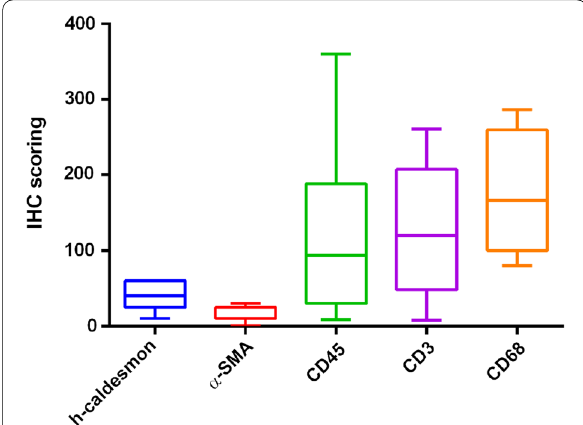
Fig. 1 Immunohistochemistry scoring of h‑caldemon, α‑smooth muscle actin (α‑SMA), CD45, CD3 and CD68 investigated in this study. α‑SMA and h‑caldesmon stains were used to quantify the percentage of the fibrous rupture of the tunica media of the muscular arteries CD45, CD3, and CD68 stains assessed the count of leukocytes, T lymphocytes, and macrophages per 10 high magnification ( fields, respectively